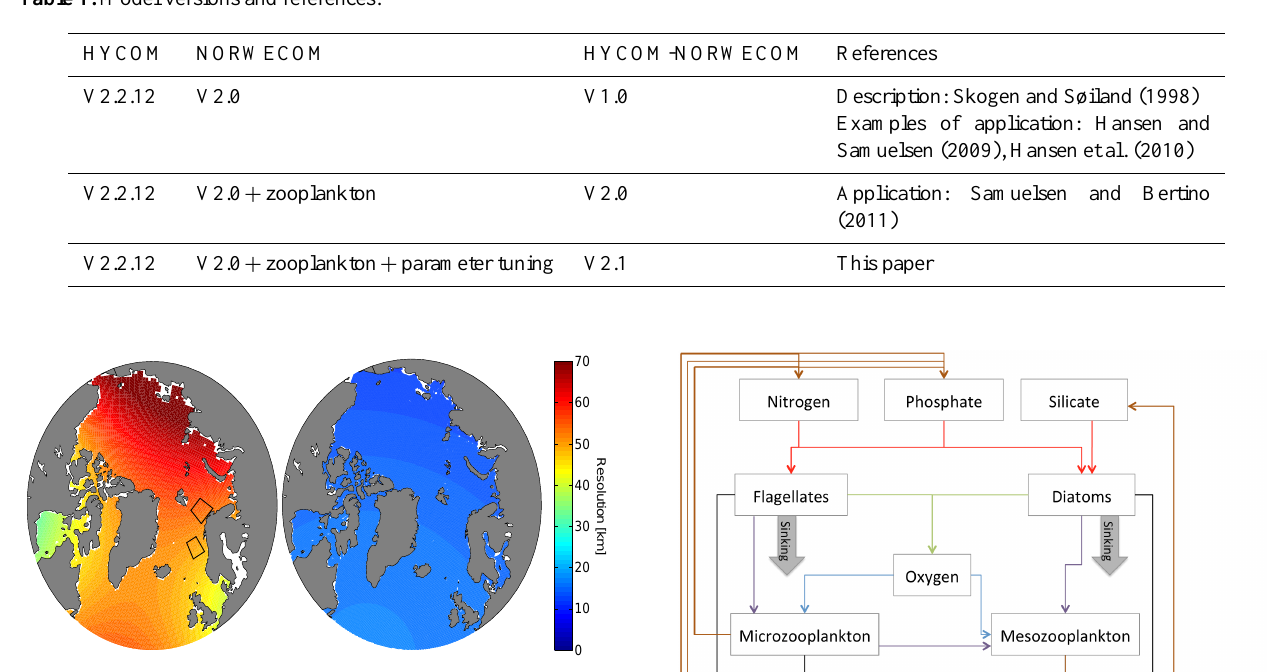
Figure 1. Resolution of the two model grids used in this study. The two areas indicated by black lines in the map to the left are the areas referred to as Norwegian Sea – southern area – and Barents Sea – northern area.